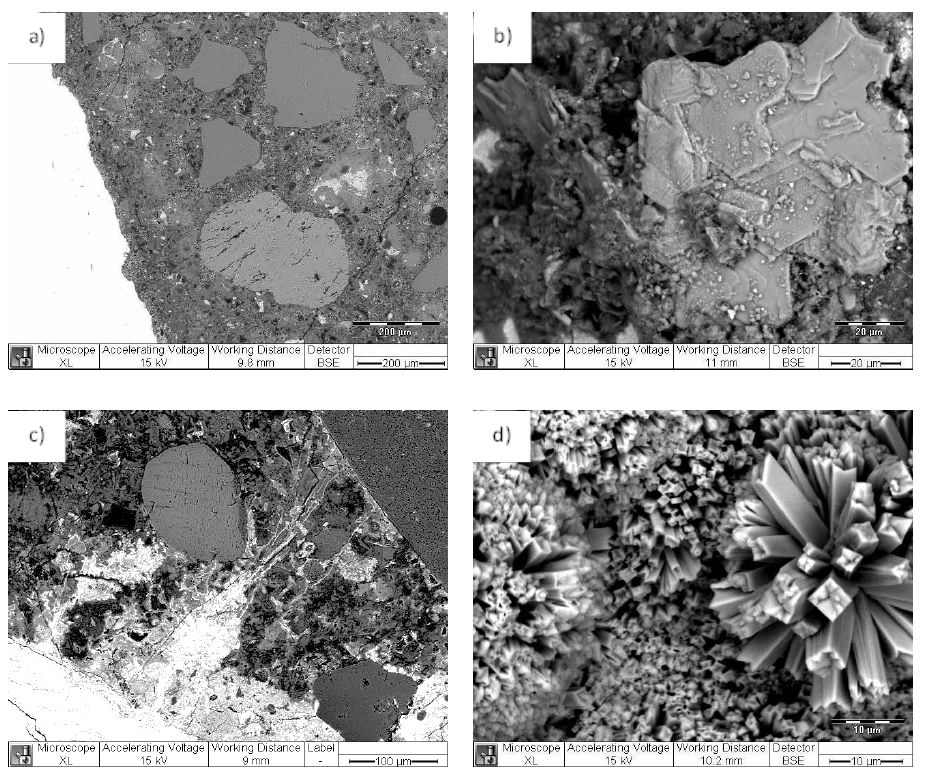
Figure 3. ESEM micrographs: steel/cement-paste interface in reinforced mortar ( a , c ) and product layer on the steel surface ( b , d ) for a control, non-corroding ( a , b ) and a corroding specimen ( c , d ).